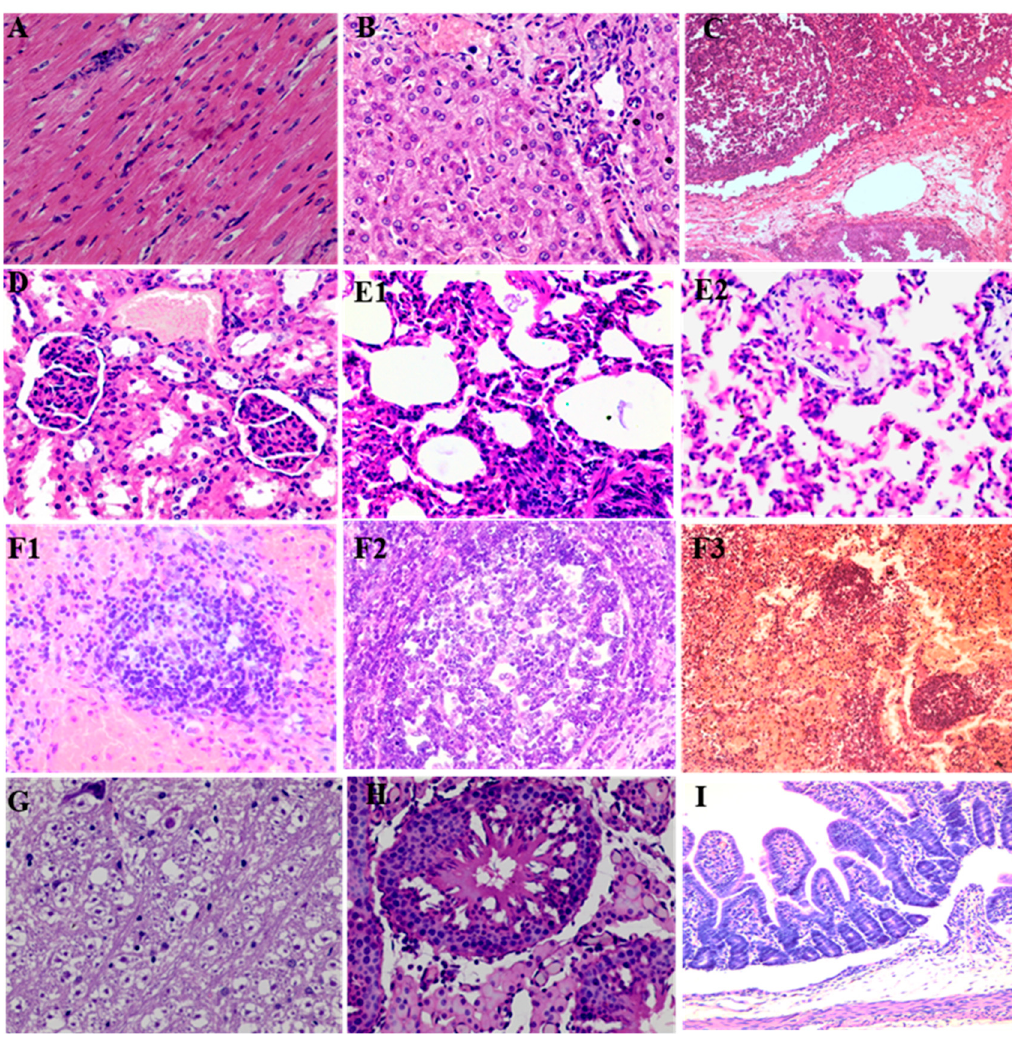
Figure 3. The histopathology change in hearts ( A ), livers ( B ), spleen ( C ), kidney ( D ), lung ( E1 , E2 ), lymph nodes ( F1 – F3 ), brain ( G ), and testis ( H ), small intestine ( I ).